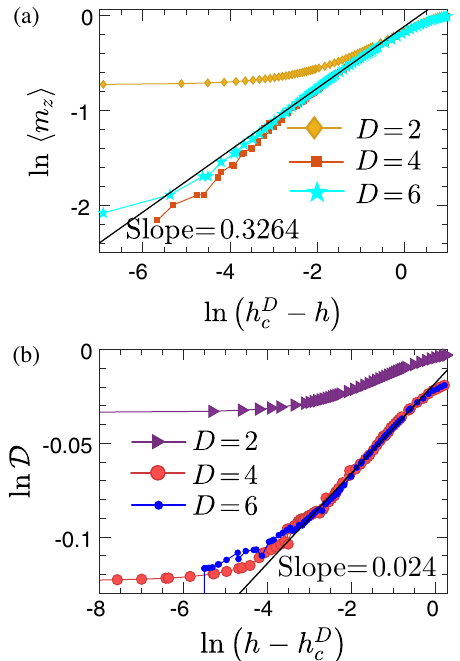
FIG. 13. Critical scaling for order parameter and disorder parameter at the phase transition. As for the toric code, we find that convergence is reached starting from bond dimension D ¼ 4 , while D ¼ 2 is overly restricted due to the symmetries. (a) For the order parameter h m , we recover the well-known scaling of the z i 3D Ising universality class. (b) For the disorder parameter D , we observe a new critical exponent β (cid:2) ≈ 0 . 024 , which matches the critical exponent observed for the deconfinement fraction in the toric code